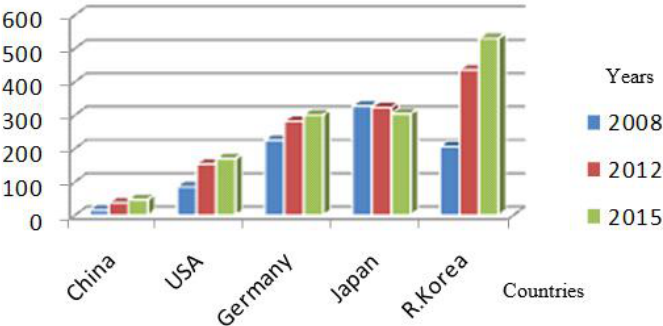
Fig. 7: The representation of industrial robots per 10.000 workers in the industry production processes in Republic of Korea, Japan, Germany, USA and China for the period 2008-2015 (Karabegović and Doleček, 2014; Karabegović and Husak, 2016; Rochricht,